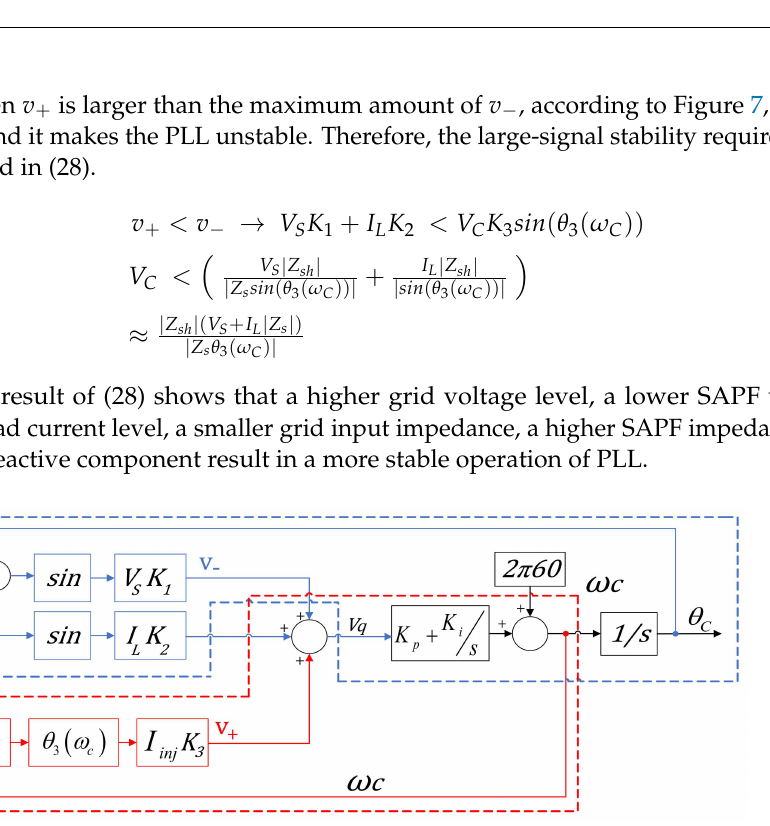
Figure 7. Small signal model of the PLL including synchronization signals by considering the interaction between the grid and SAPF. In addition to the grid-synchronization loop, another “self- synchronization” loop appears in the proposed model, representing the injection current effect. The output of the self-synchronization loop v + can be considered as a disturbance to the PLL loop, which prevents θ C and θ S from